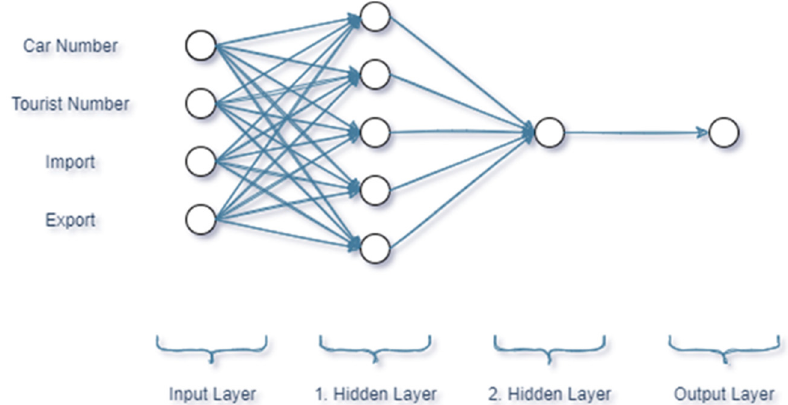
Figure 8. Structure of ANN model used in this study for Gokceada Island.